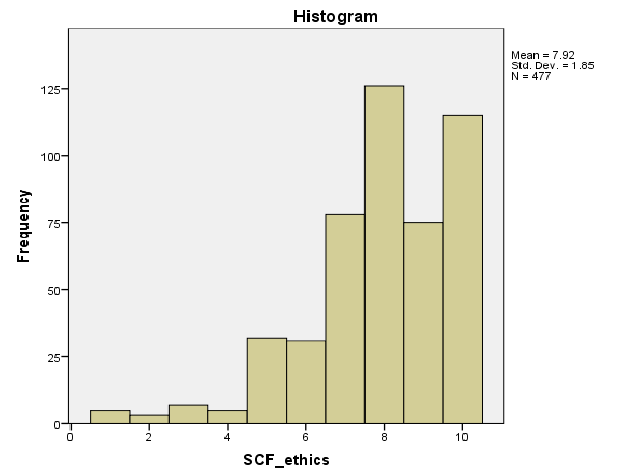
Fig. 1. EB frequency histogram. Source: authors’ calculations.